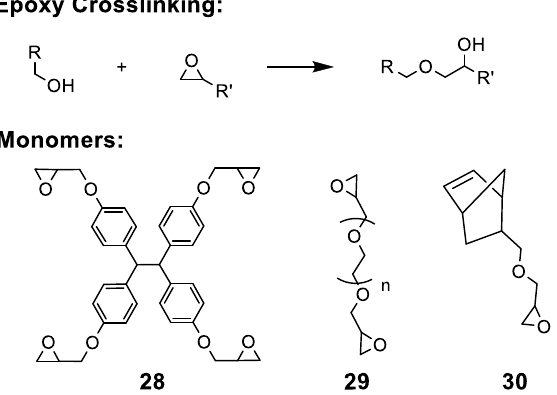
Figure 17. Epoxy esterification crosslinking mechanism and functional monomers.